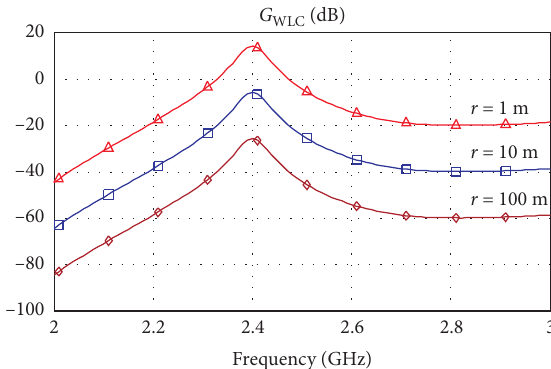
Figure 12: The wireless connection gain as functions of